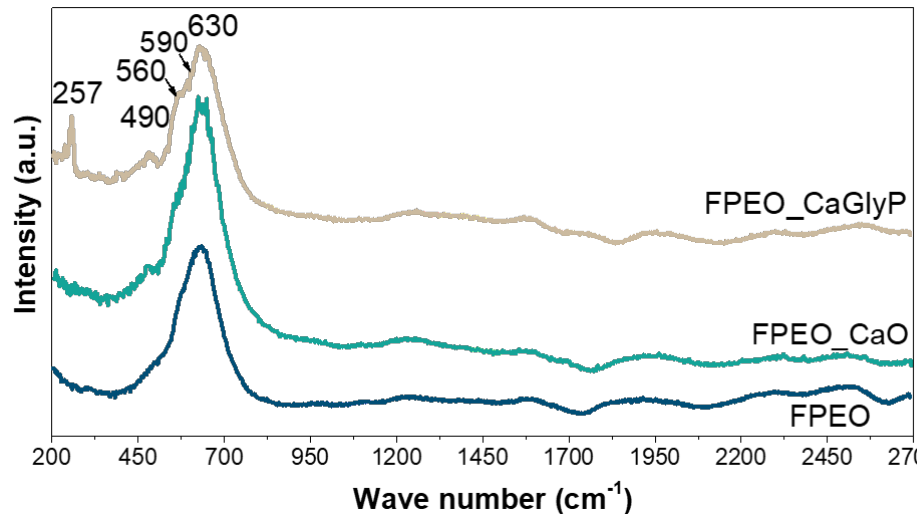
Metals 2020 , 10 , x FOR PEER REVIEW Figure 4. Grazing angle XRD patterns of the FPEO coatings. Figure 4. Grazing angle XRD patterns of the FPEO coatings.